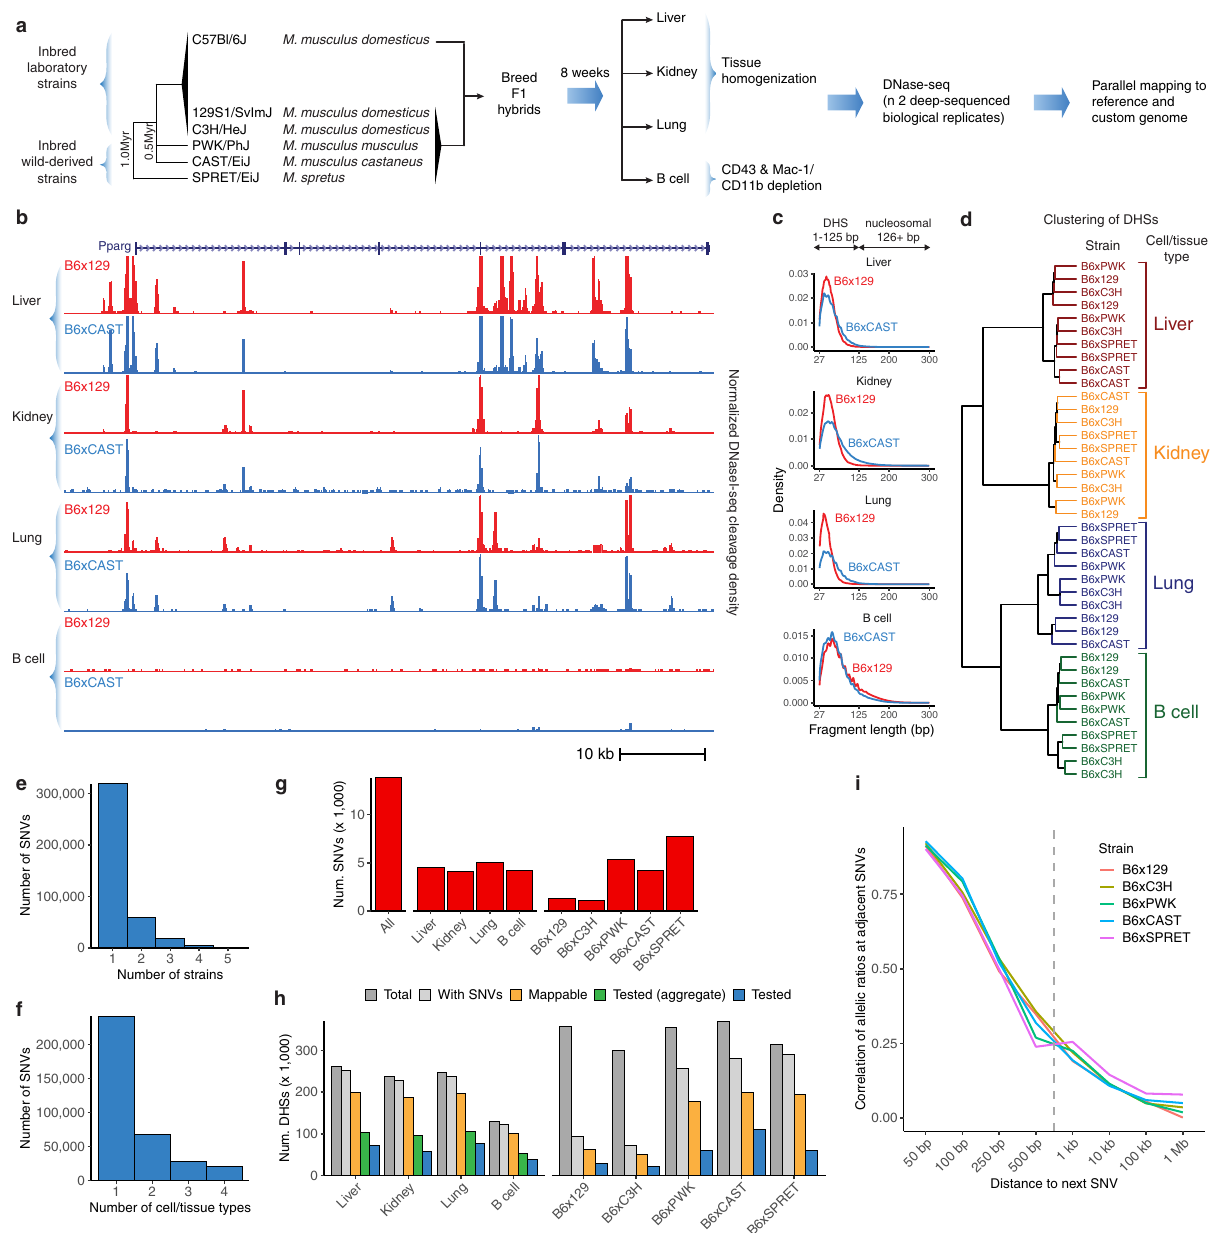
Fig. 1 Allelic analysis of DNA accessibility in hybrid mice from diverged strains. a Overall schematic of experiment b . DNase-seq pro fi les at the Pparg locus in liver, kidney, lung tissue, and B cells from F1 crosses of C57Bl/6J dams with 129/SvImJ and CAST/EiJ sires. c Fragment length distribution of samples showing high-quality libraries comprising non-nucleosomal fragments. d Hierarchical clustering of DHSs from high-depth samples. e – f Counts of SNVs shared across strains ( e ) and cell types ( f ). g Counts of imbalanced SNVs (FDR 10%). Counts are reported in aggregate across all data sets (left), by cell type (middle), and by parental strain (right). h Summary of the master list of DHSs overlapping SNVs from all strains. Counts include all DHSs (dark gray), DHSs with SNVs (light gray), DHSs passing mappability fi lters (orange), DHSs with suf fi cient coverage to test for imbalance across all data sets (green) and in individual cell types or strains (blue). Counts include only autosomal DHSs. i Pearson correlation of allelic ratios at adjacent SNVs broken down by distance to next SNV. The dashed line represents the median width of DHS hotspots overlapping SNVs in this